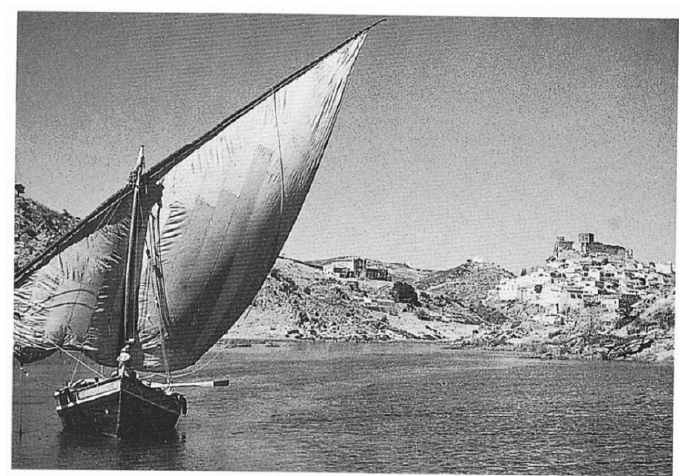
Figure 1. Mértola. Photo took by author.